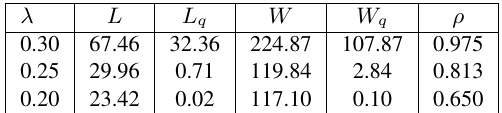
Table 4: Jellyfish M/M/C model with 36 cores for different image